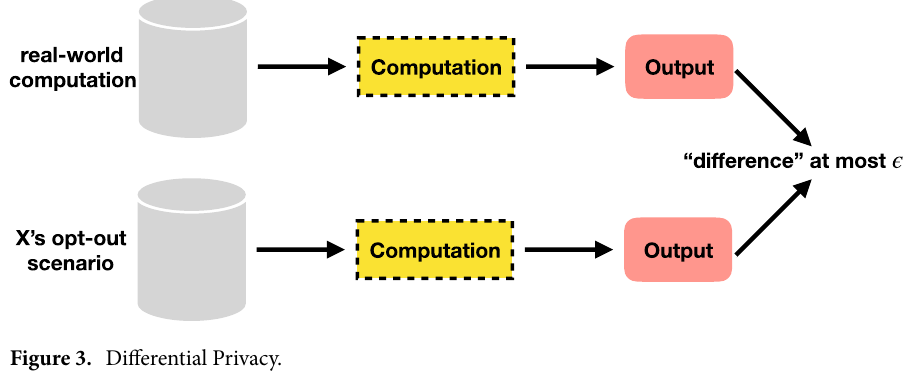
Figure 3. Differential